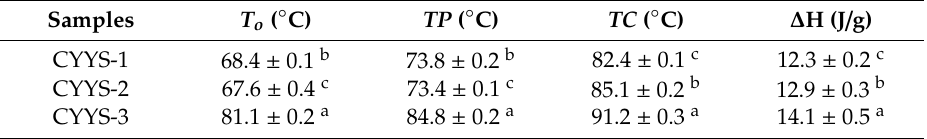
Table 3. Thermal properties of CYYS-1, CYYS-2, and CYYS-3.